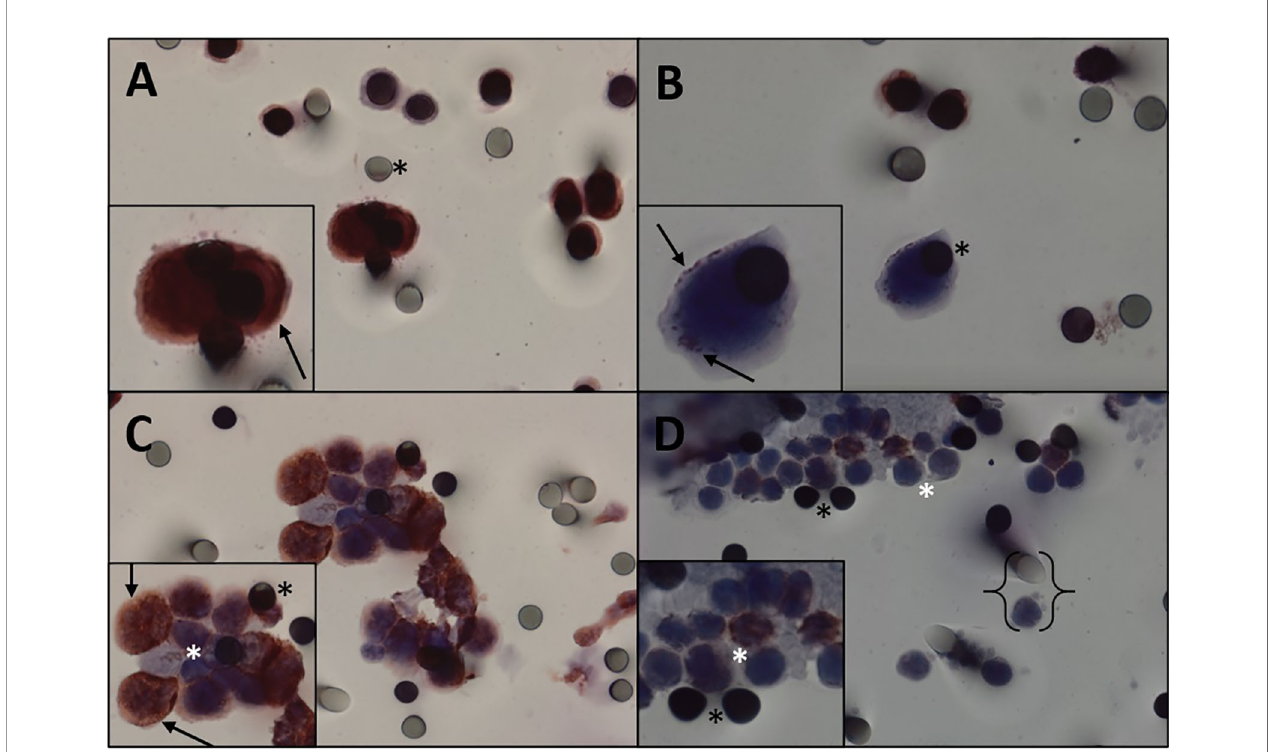
FIGURE 3 | Immunocytochemistry for vimentin. (A, B) Immunocytochemistry of CTC with vimentin antibody and counterstaining with DAB. (A) High staining. (B) Weak staining. (C) Desmoid tumor CTMs observed in the blood fi ltered using the ISET, stained with vimentin and counterstained with DAB chromogen. (D) Leukocytes from desmoid tumor patient. Black asterisk: membrane spots. Black arrows: vimentin expression. White asterisk: leukocytes. Keys: size comparison between a leukocyte and a spot. CTC, circulating tumor cell; CTMs, circulating tumor microemboli; ISET, isolation by size of epithelial tumor